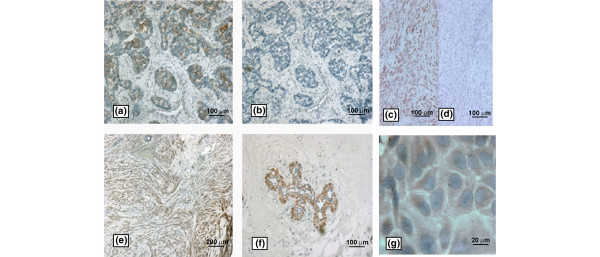
Expression of 1α-hydroxylase in breast cancer. Immunohistochemical analysis of 1α-hydroxylase expression in (a) ductal breast cancer, (e) lobular breast cancer, (f) normal breast and (g) MCF-7 cells. (c) Expression of VDR in lobular breast cancer. Control sections were exposed to (b) 1α-hydroxylase and (d) VDR peptide antisera pre-incubated with immunizing peptide.